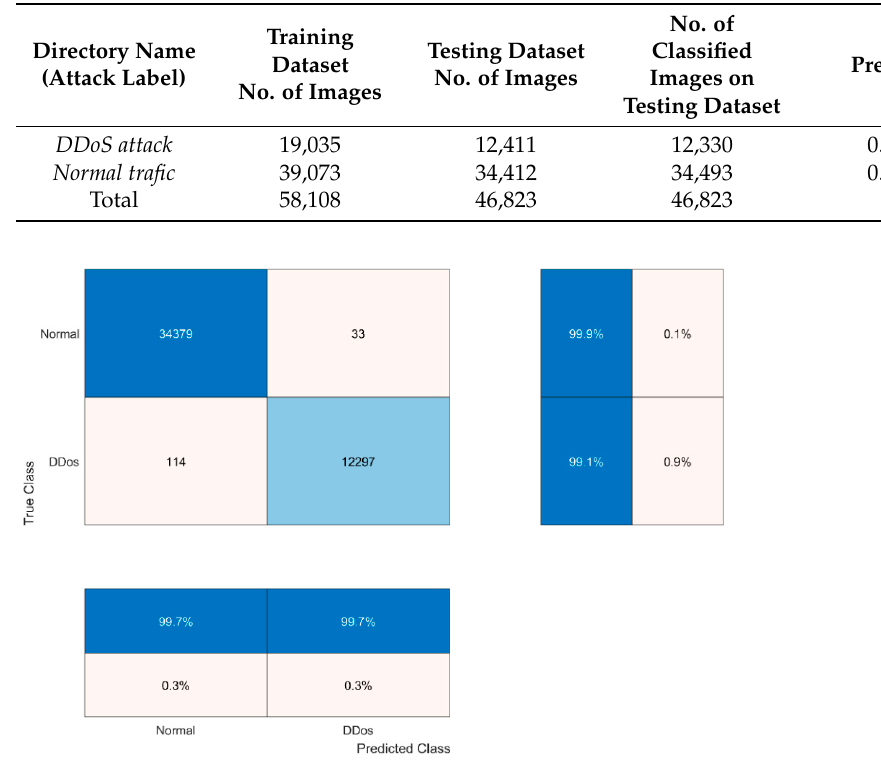
Figure 14. Confusion matrix of attack recognition using ML.NET created model on BOUN DDoS training dataset.